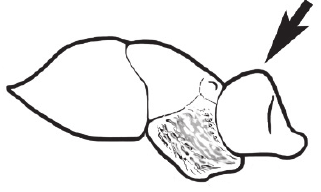
distinctly broader, CI ≥ 85 ........................................................................ 50 50 Minor worker (major worker unknown) with propodeum produced vertically and conical in profile; propodeal spiracle very large, approximately 0.75× height of propodeum; eye larger (eye length approximately 0.40× length of side of head capsule) (two pins, Gawler Ra., SA) (Fig. 47a–d)....... turbineus